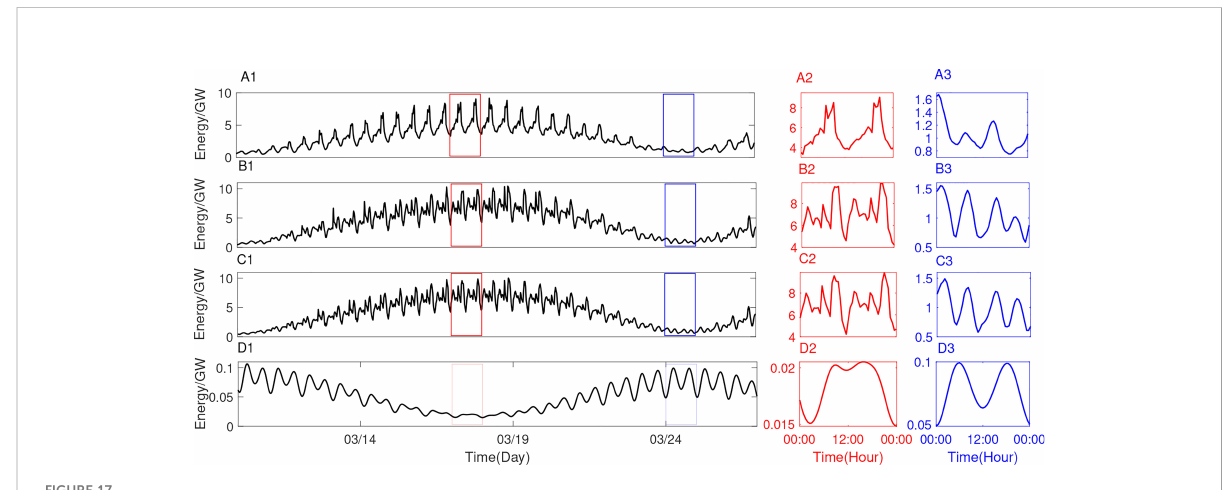
FIGURE 17 Same as Figure 16, but for baroclinic energy fl ux divergence.